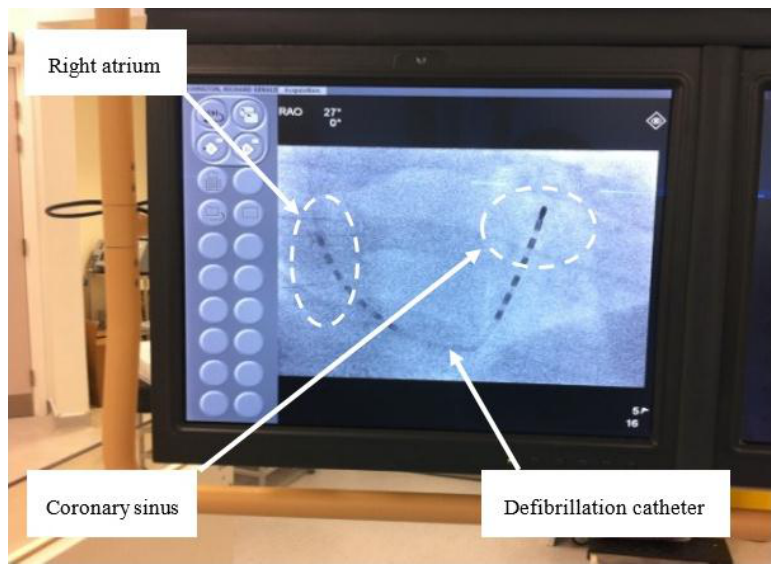
Figure 4. Position of defibrillation leads in the right atrium (RA) and coronary sinus (CS) for internal cardioversion of AF (right anterior oblique view).